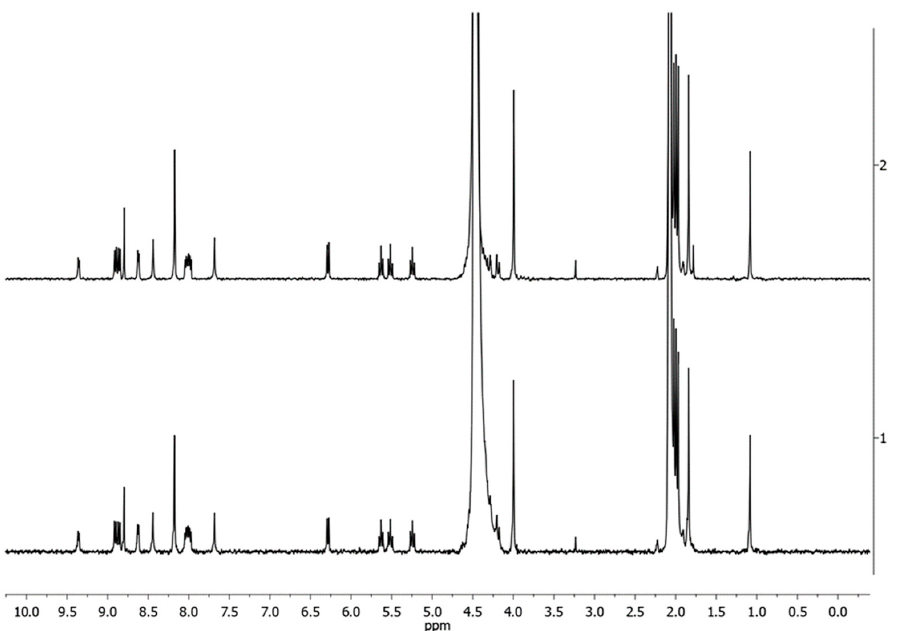
Figure 4. 1 H NMR spectra of 4Pt-im in 1:1 v/v D 2 O:acetone- d 6 over time at 400 MHz, 298K (trace 1 =